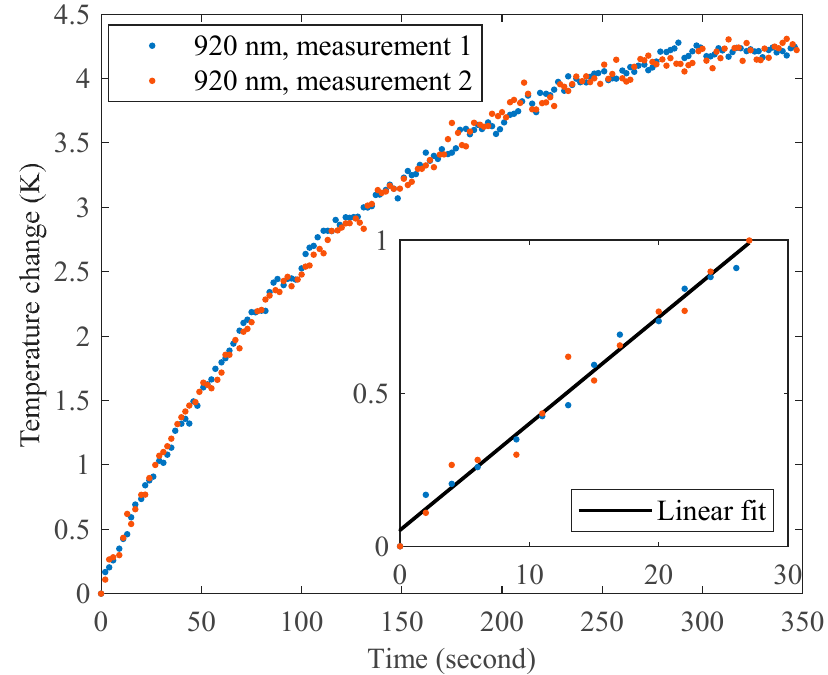
Figure 9. Temperature change versus time based on DLT measurements in Yb:YLF with pump power of 0.8 W at λ = 920 nm. At this wavelength, the sample heats. A linear fit to the temperature change for the initial excursion in temperature of ∆ T = 1 K had a slope of 3.48 × 10 − 2 K/s